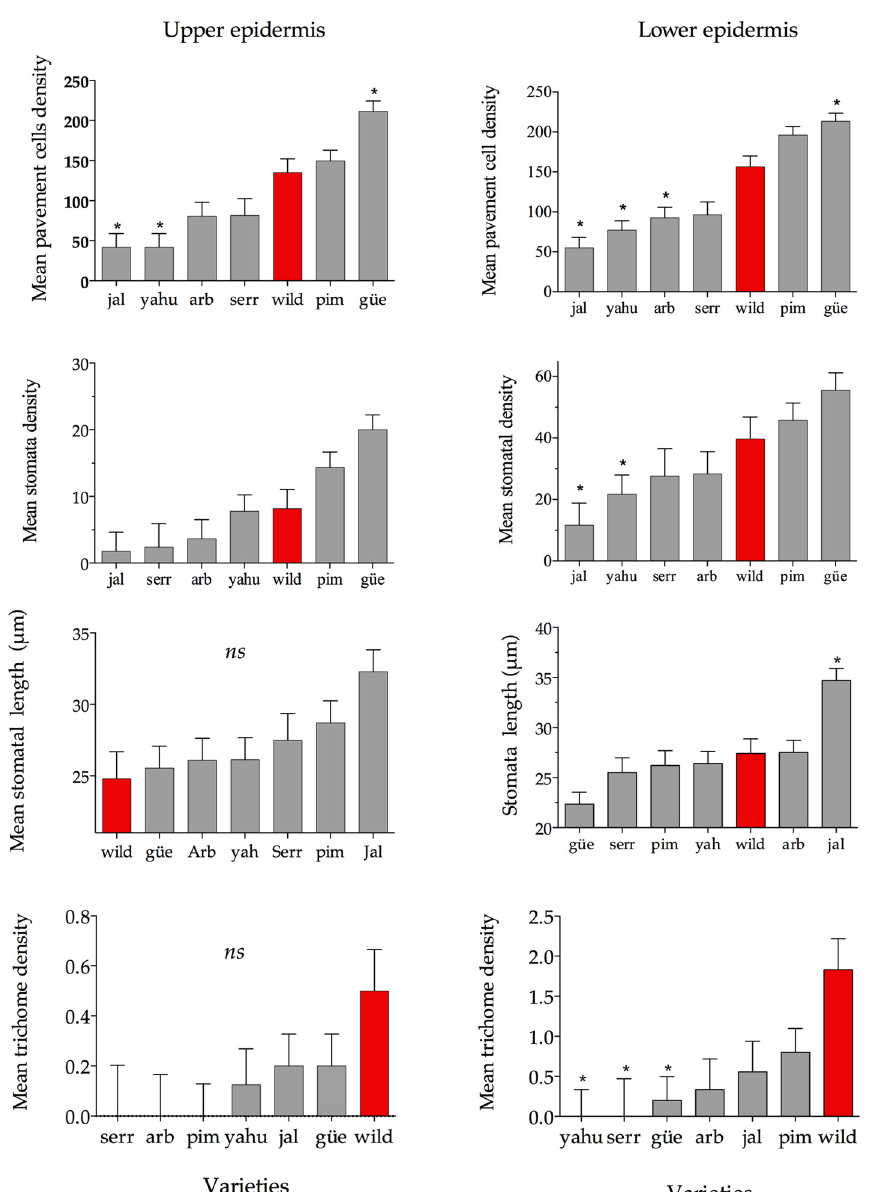
Figure 4. Independent ANOVA of the upper and lower epidermis for pavement density, stomatal density, length, and trichome density. Red bars indicate the mean and 1 ± SE for the wild variety. Gray bars indicate the mean and SE of the cultivated varieties. The asterisks indicate which cultivated variety significantly differs from the wild variety after Tukey’s HSD test ( α =0.05).